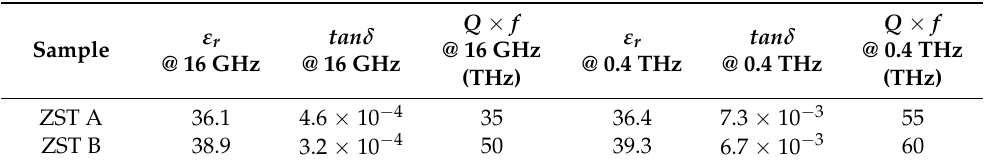
Table 2. Relative permittivity ( ε r ), dielectric loss ( tan δ ) and Q × f product of ZST samples measured in the microwave (@ 16 GHz) and terahertz (@ 0.4 THz) domains.